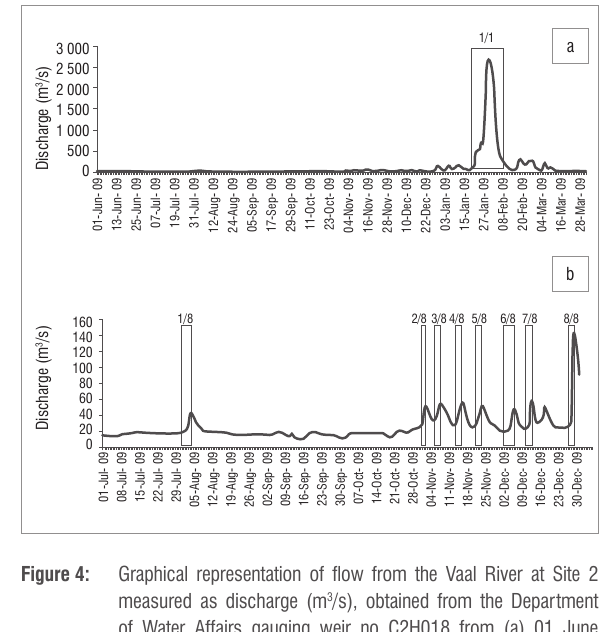
Graphical representation of flow from the Vaal River at Site 2 measured as discharge (m 3 /s), obtained from the Department of Water Affairs gauging weir no C2H018 from (a) 01 June 2009 to 31 March 2010 and (b) 01 July 2009 to 31 December 2009. The flood event (4a, 1/1) and freshet events (4b, 1/8–8/8) considered in the study are indicated.